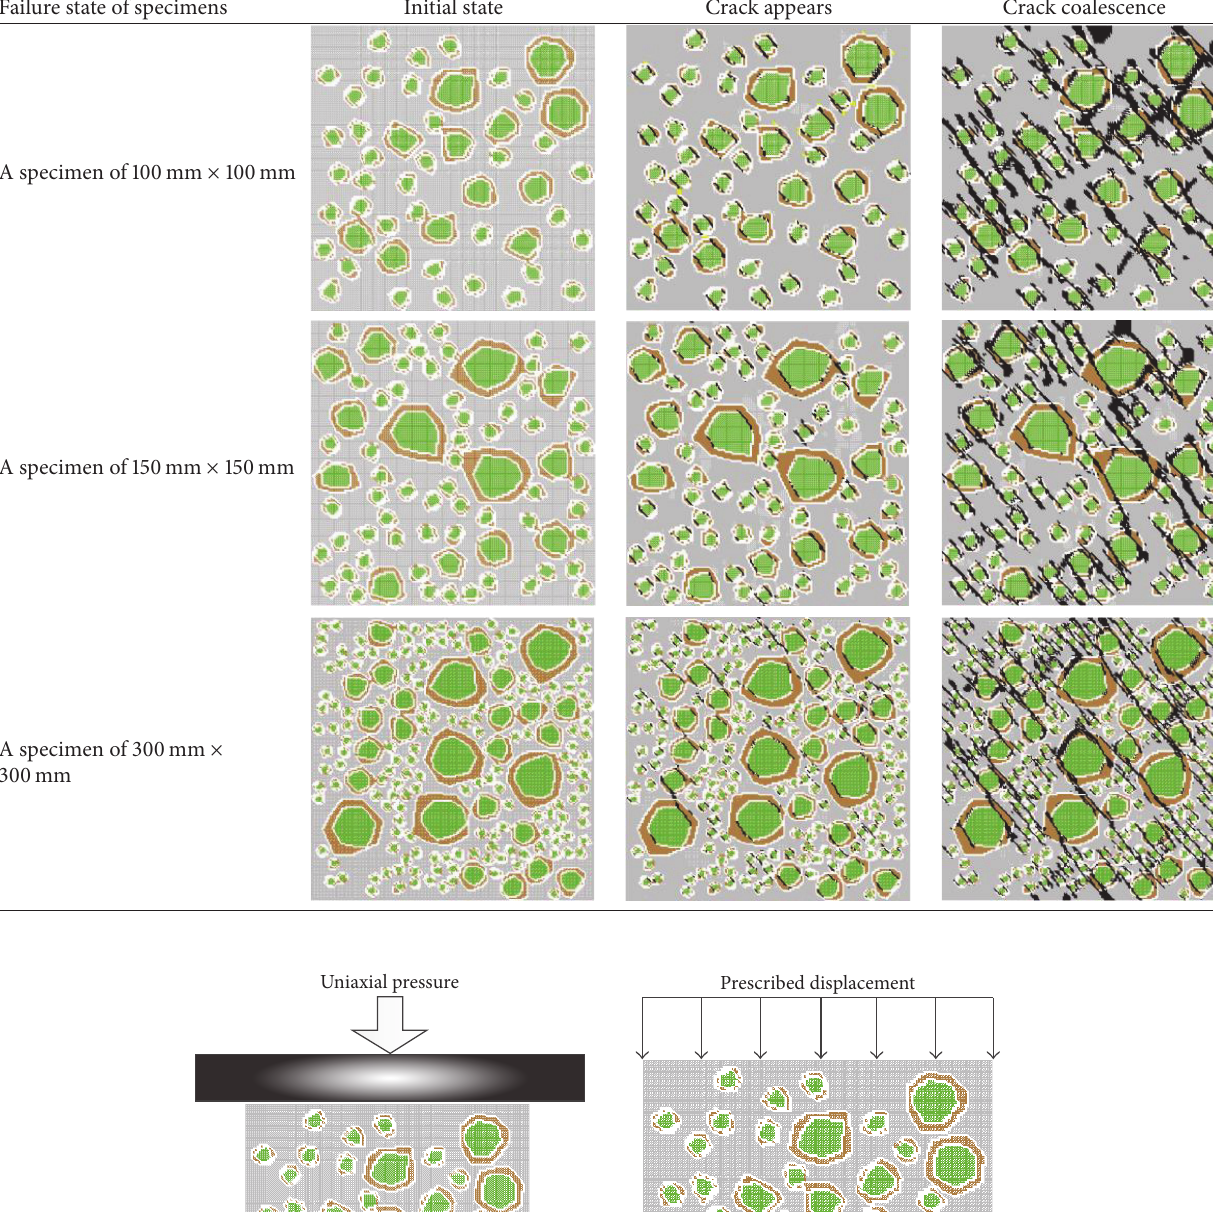
Table 2: The failure patterning of different size of RAC specimens under uniaxial compression.